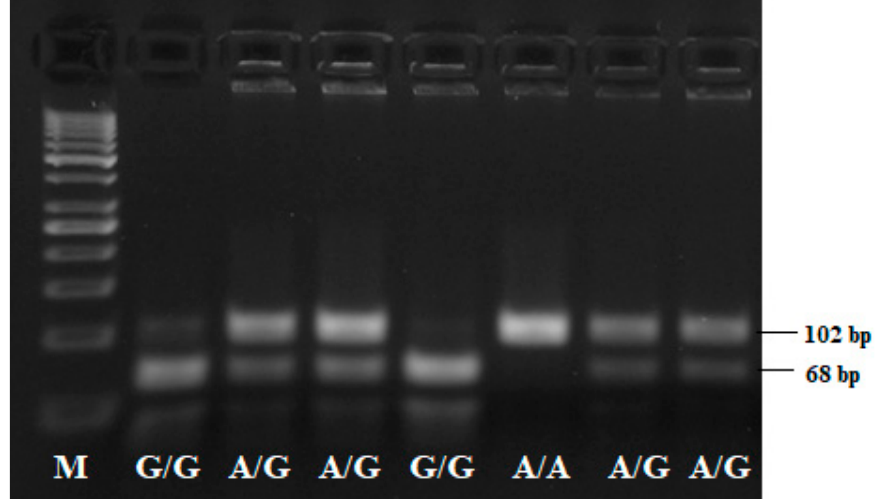
Figure 1. RFLP-PCR electropherogram representing the IL17A -197 A/G genotypes. A/A-genotype was detected with the uncut 102 bp DNA fragment; the A/G-genotype was visualized with two bands of 102 bp and 68 bp; the homozygous G/G-genotype exhibited a 68 bp band. The 38 bp fragment was too short to be detected. The M line was the 50 bp DNA marker.